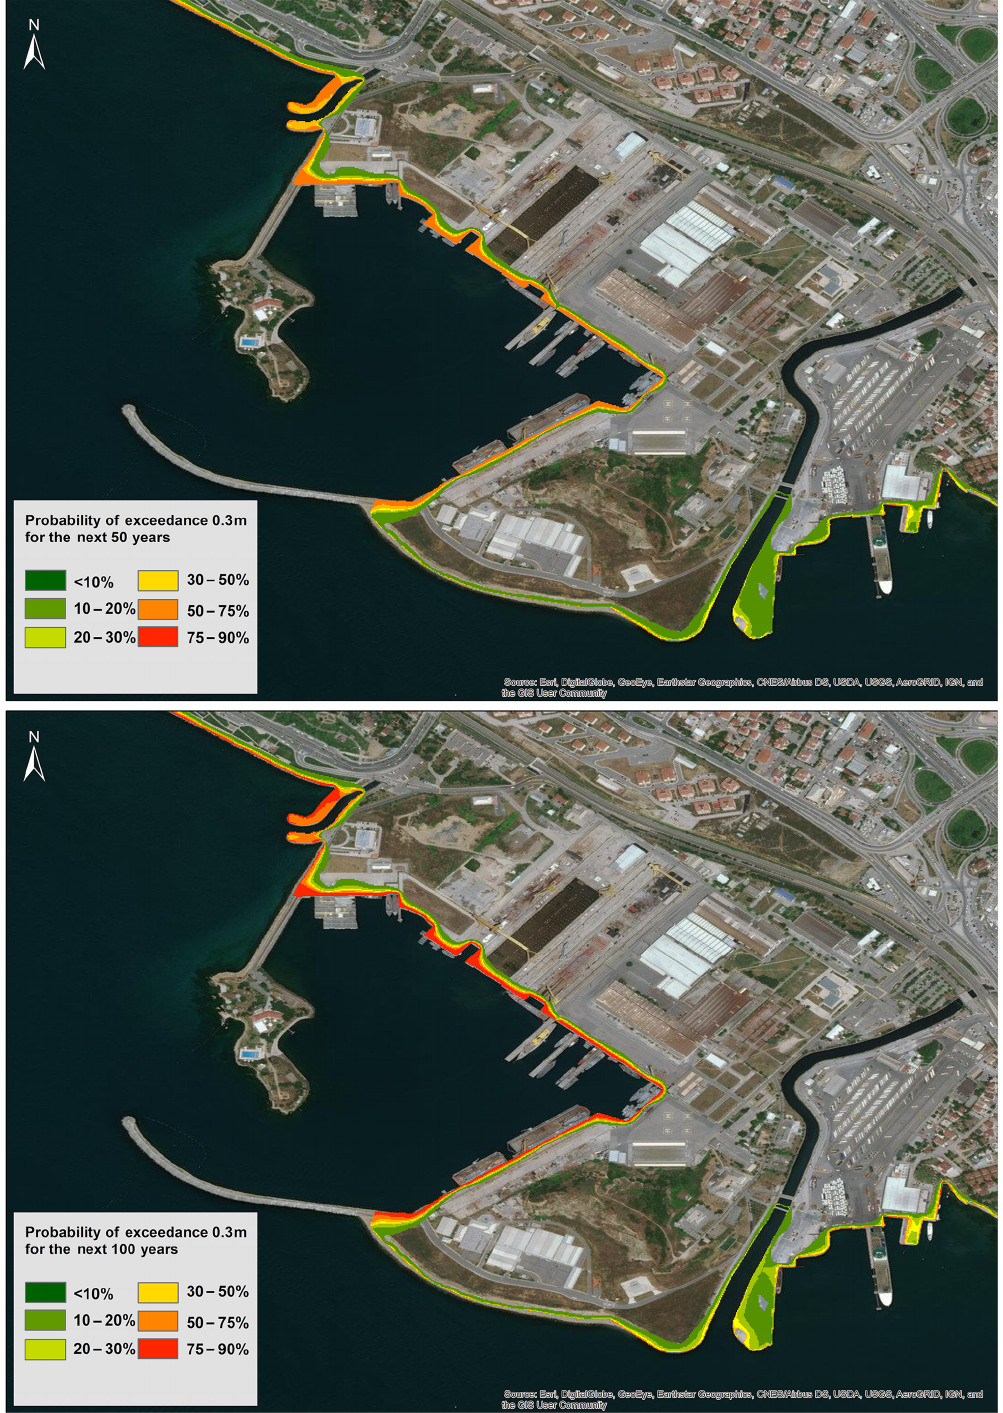
Figure 9. Probabilistic tsunami inundation maps of the northern part of the Tuzla study domain representing the probability of exceedance of 0.3m inundation depth for the next 50 and 100 years. Change of colors from green to red represents the increasing probability of exceedance (created using ArcMap version